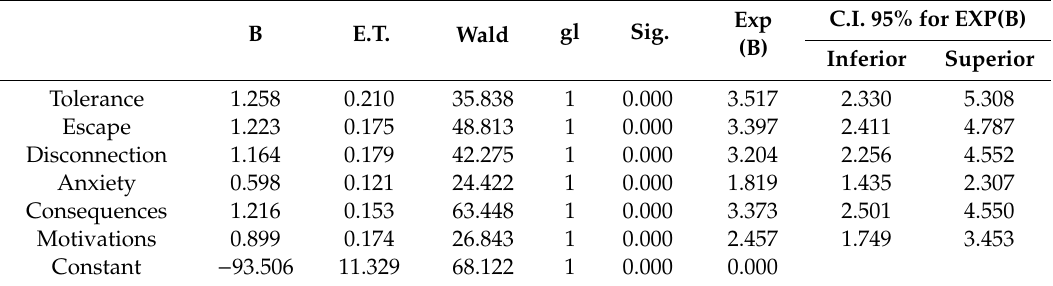
Table 7. Binary logistic regression of the self-perception of the problematic Smartphone use a of male university students with respect to the MPPUSA.